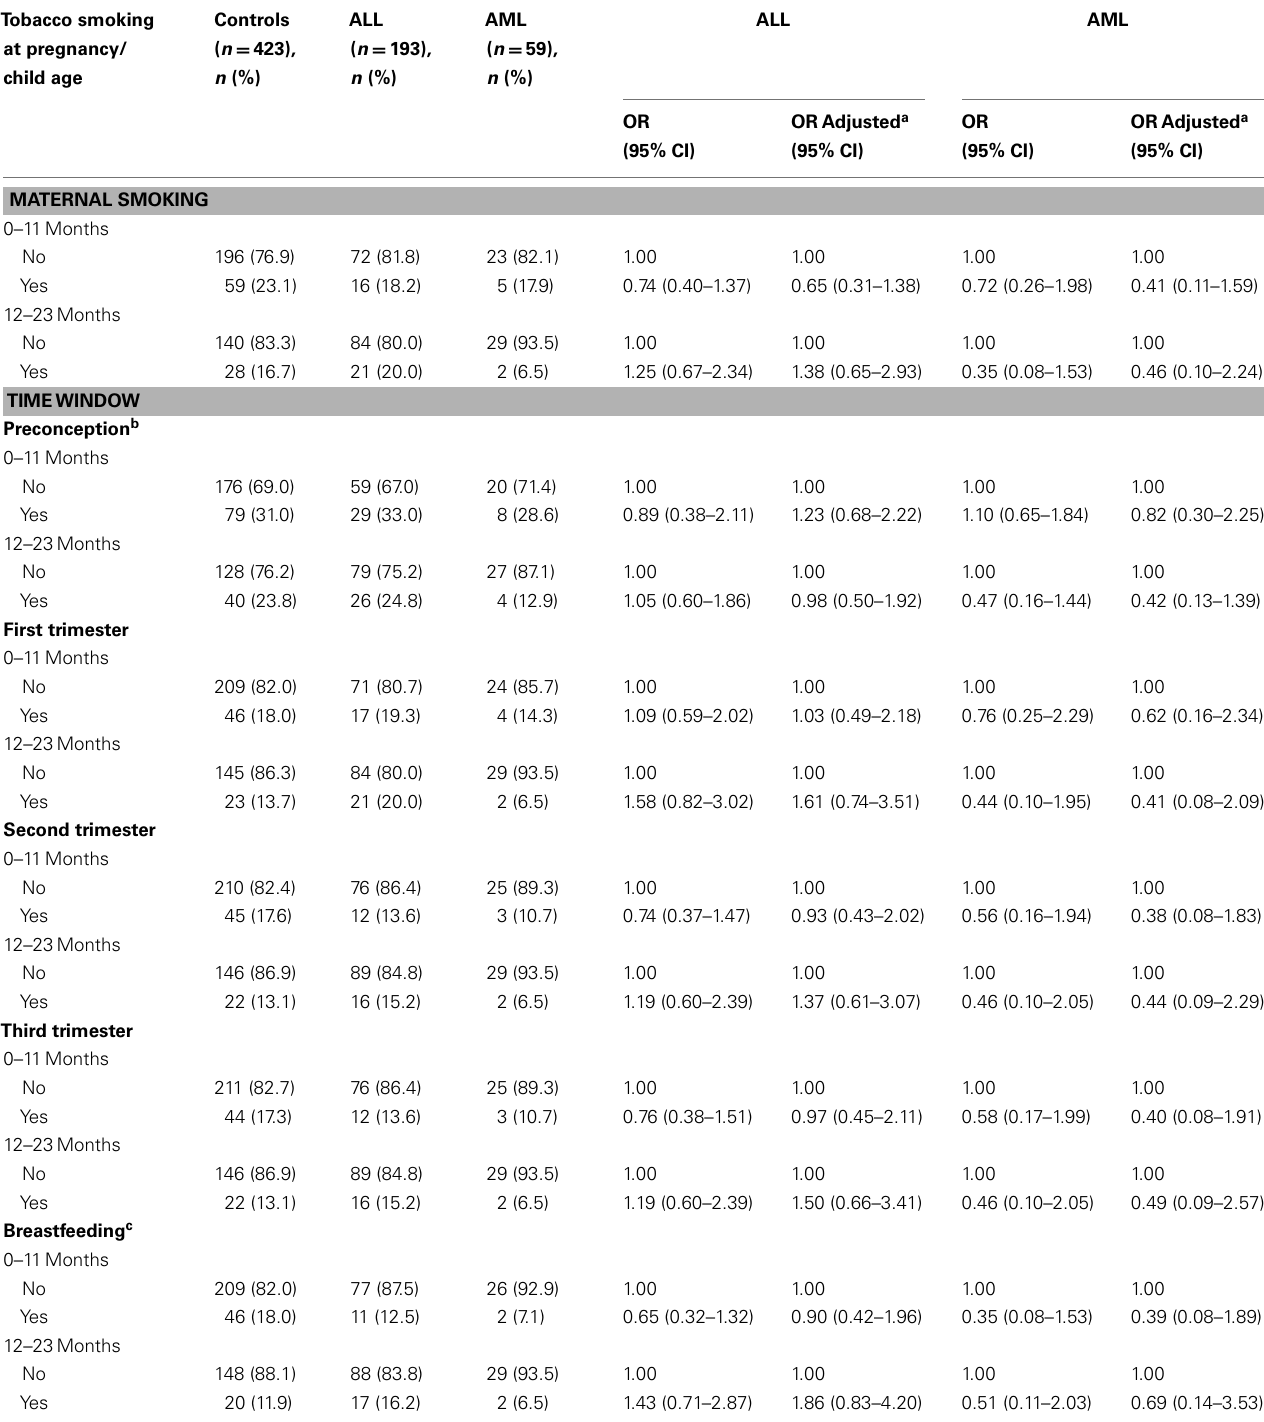
Table 2 | Maternal smoking during pregnancy according to offspring age strata, leukemia cases, and control mothers, children < 2year, Brazil,